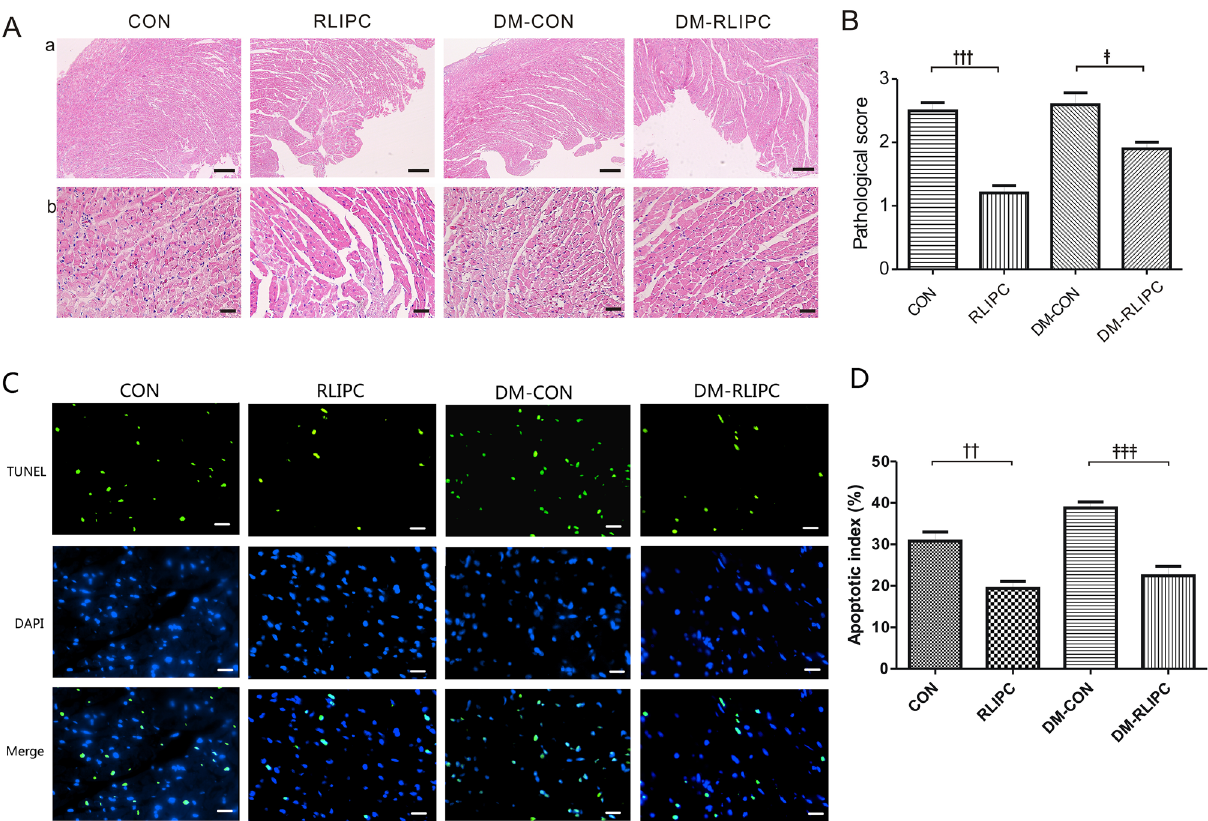
Figure 5. Effect of RLIPC on morphological changes post-myocardial ischemia/reperfusion. ( A ) Representative (of n = 5 rats/group) H&E stained heart sections are shown. Panel (a) scale bars: 100 μm; panel (b) scale bars: 10 μm. Sham, sham surgery; CON, LAD ligation; RLIPC, remote liver ischemic preconditioning; DM: diabetic rats. ( B ) Morphological evaluation of myocardium damage in each heart (n = 5 mice per group). The severity of myocardial damage was graded from 0 to 3 (see the ‘Methods’ section). Data were presented as mean ± SEM; ††† p < 0.001 compared with CON; and ‡ p < 0.05 compared with DM-CON (by one-way ANOVA). ( C ) Representative TUNEL-stained heart sections. TUNEL-positive (green) cardiomyocytes were identified as apoptotic cells. Scale bars: 10 μm. ( D ) Bar graph showing the average percentage of TUNEL-positive nuclei in the ischemic regions (n = 5–6 rats per group). †† p < 0.01 compared with CON; and ‡‡‡ p < 0.001 compared with DM-CON (by one-way